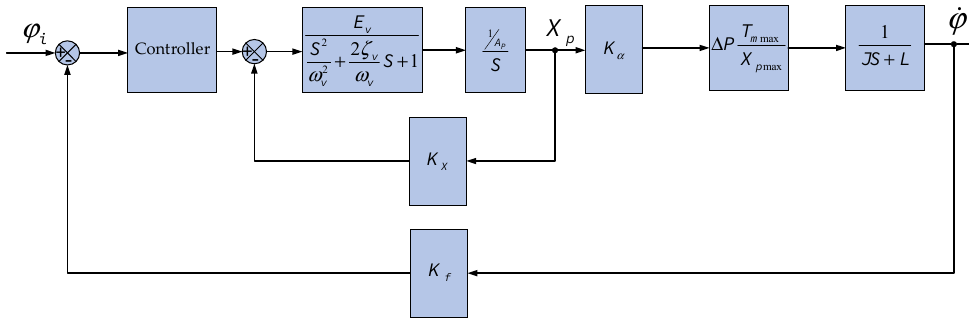
Figure 2. Block diagram model of PMSS. Table 3. Main parameters for simulation model.